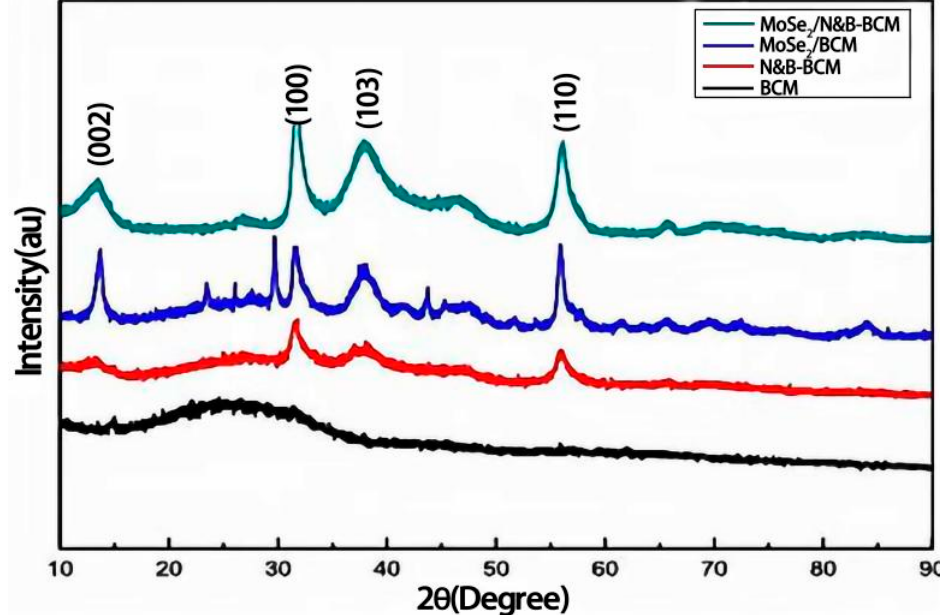
Figure 2. XRD patterns of MoSe 2 /N&B-BCM, MoSe 2 /BCM, N&B-BCM, and